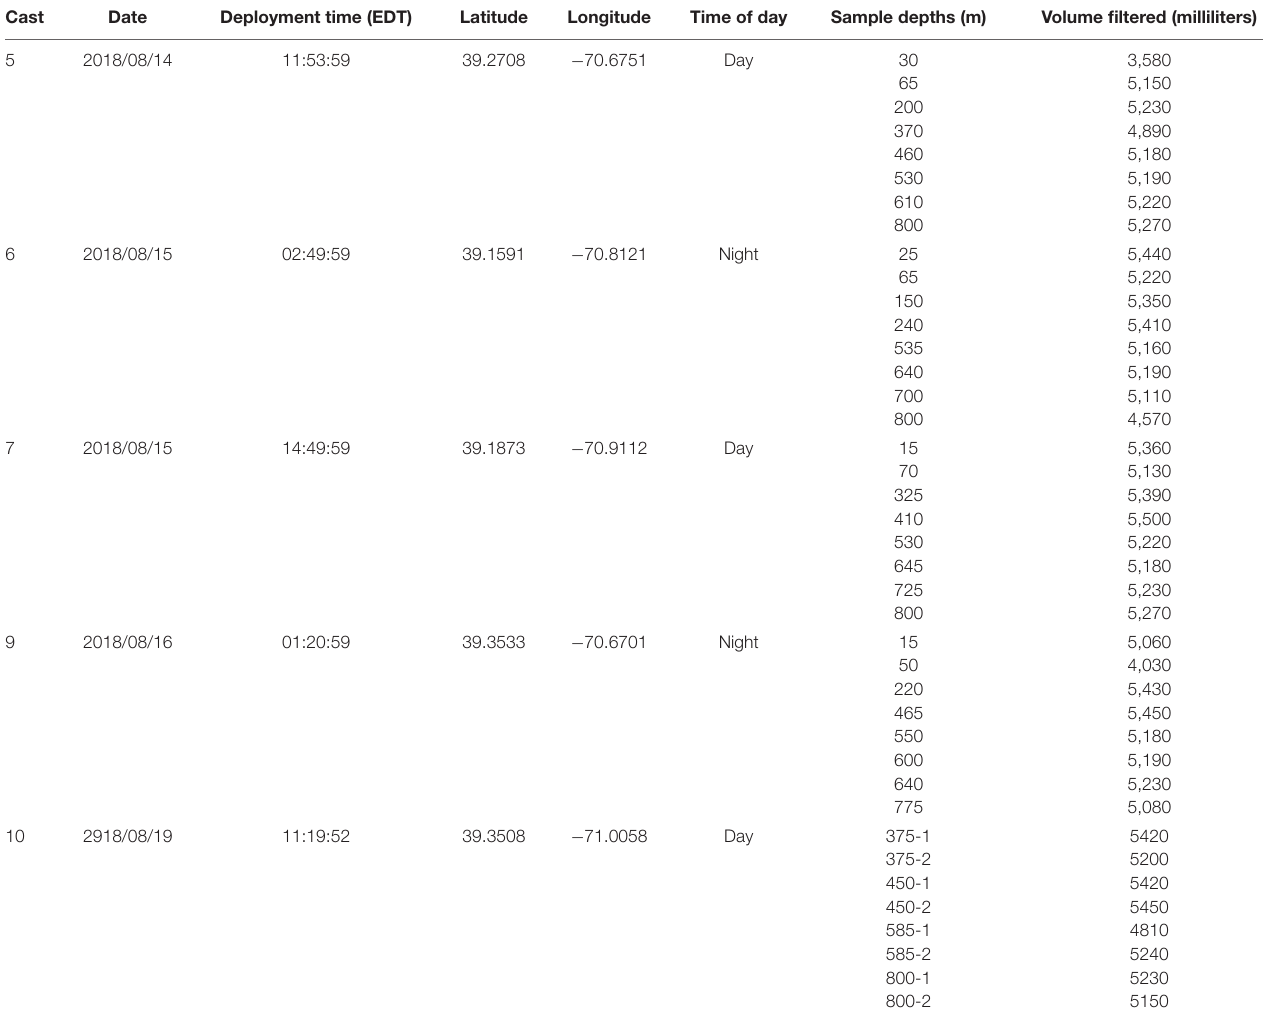
TABLE 1 | Environmental DNA sampling